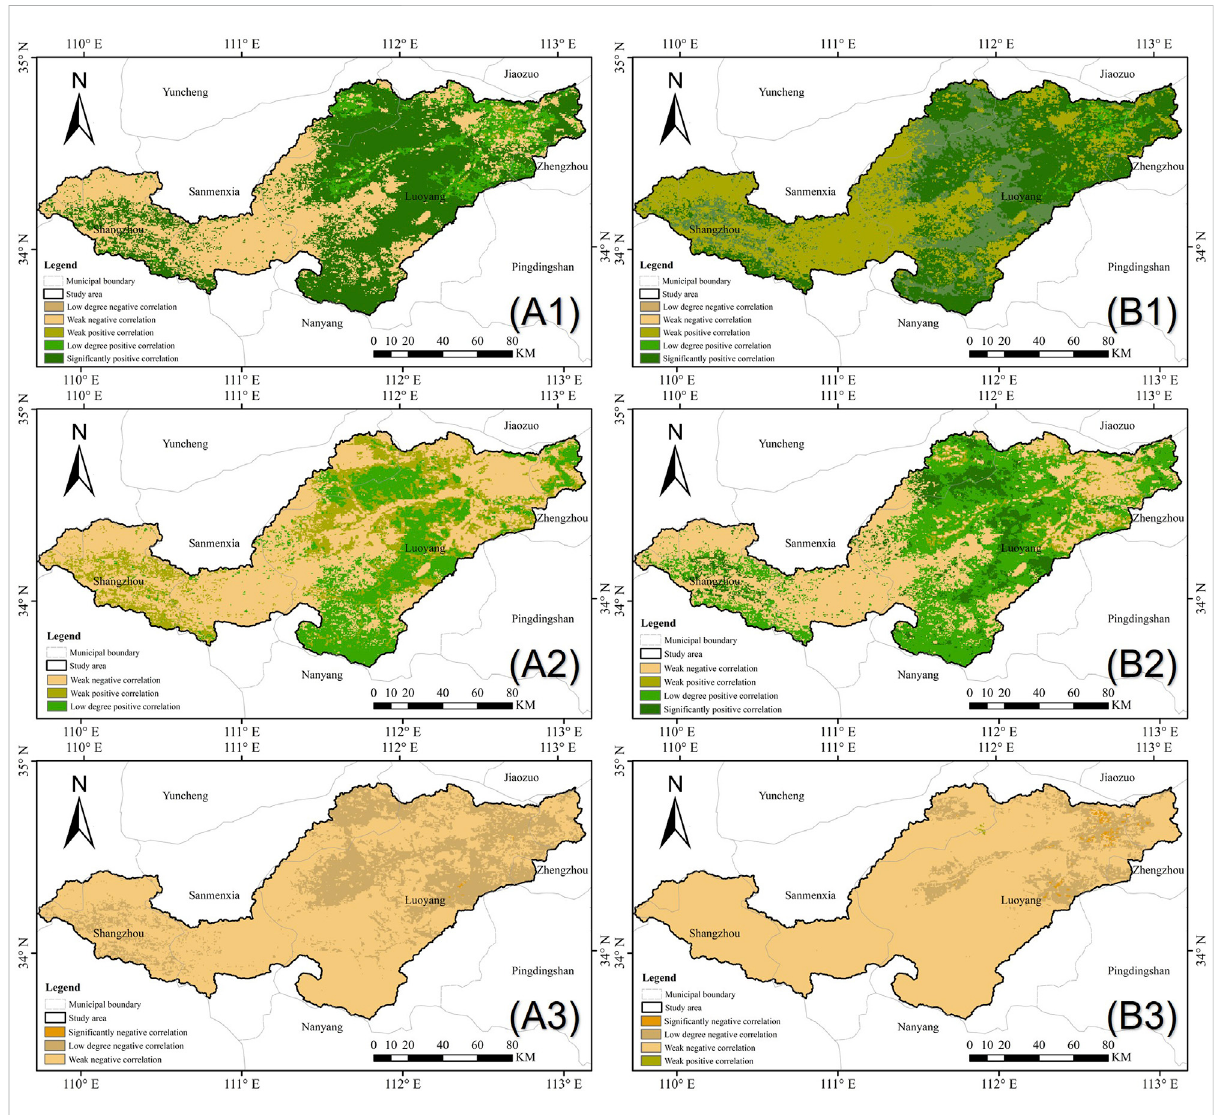
FIGURE 9 Spatial distribution of correlation coef fi cients between NPP and precipitation (A) and air temperature (B) with different lag times (1 month and 2 and 3 months). (A1 – B3) part labels represent the delayed months, (A) and (B) respectively represent precipitation and temperature.